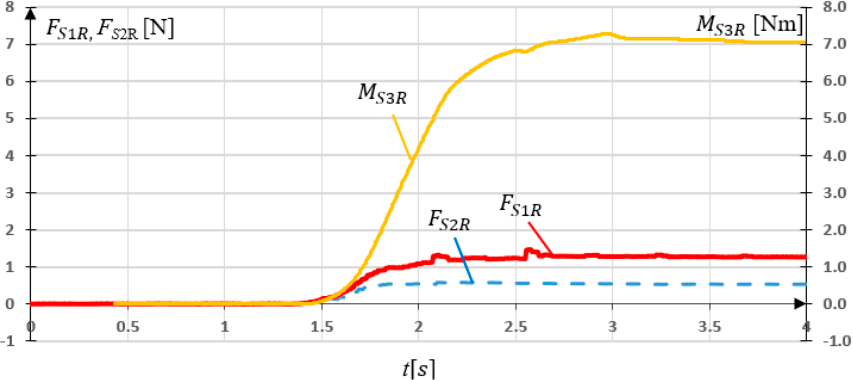
Figure 17. Experimental research results for the grip loaded with 7 Nm torque.